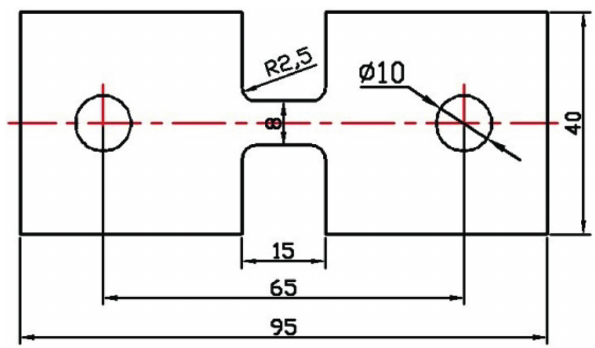
Figure 2: The dimensions of superplastic tensile specimen (mm).